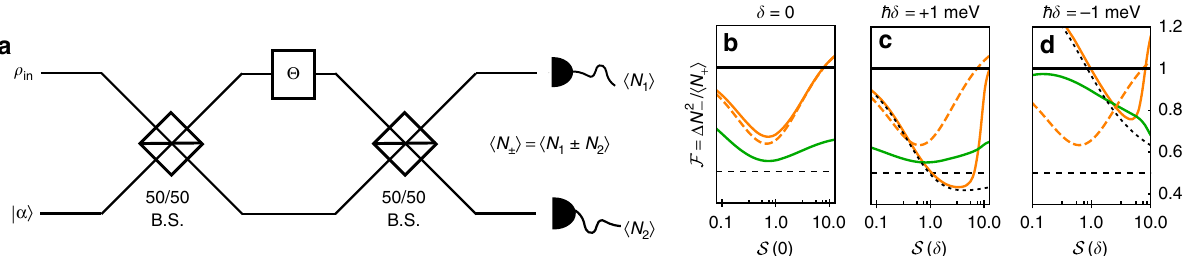
Fig. 3 Phase estimation with vibrationally enhanced resonance fl uorescence fi elds. a Phase estimation setup, showing a test input state ρ in in the fi rst (upper) mode and a coherent state input | α 〉 in the second (lower) mode of a Mach − Zehnder interferometer consisting of two 50/50 beamsplitters separating and recombining the two arms with path length difference parameterised by Θ . When the fi rst mode is illuminated with resonance fl uorescence light, the normalised phase sensitivity for Θ = π /2 is shown for resonant ( b ) and off-resonant driving ( c , d ), modelled with (solid, orange) and without (dashed, orange) coupling to phonons, and also calculated using the approximate QD steady-state in Eq. (5). Shown for reference is the normalised phase sensitivity for a squeezed vacuum input state in mode one (solid, green), with the squeezing parameter chosen such that the expectation value of the photon number is equal to that in the resonance fl uorescence case. The thick black line at F ¼ 1 is the phase sensitivity for a coherent state input in the fi rst (upper) interferometer arm, while the dashed black line at F ¼ 0 : 5 is the global minimum for the squeezed vacuum input. Parameters are as in Fig. 1 with | α | 2 =